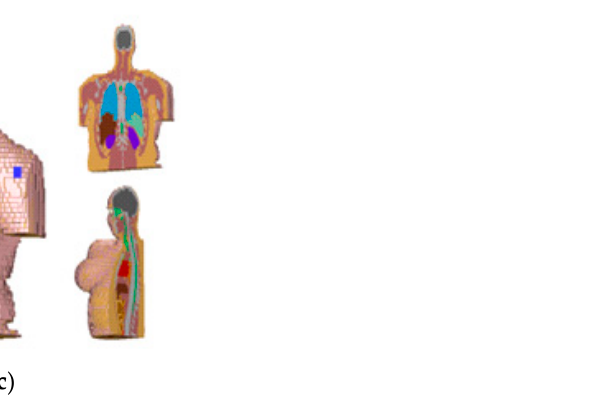
Figure 6. Impact of different bodies on antenna characteristics is shown. A fat body voxel is compared to a normal body type in Figure 4. ( a ) percentage of the resonant frequency variation in normal and overweight voxels are compared, ( b ) percentage of the bandwidth variation in the normal and overweight voxels are illustrated, and ( c ) overweight human voxel and the positions of the antenna’s placement are shown.